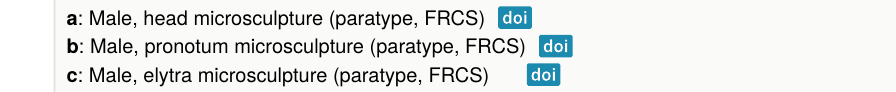
Pronotum : Broadest at the base. Base completely straight to posterior angles. Posterior angles form a right angle, while the tip of the angle itself is slightly rounded. From posterior angles to anterior angles, the pronotum is gently curved inwards. The sides and the anterior angle have a fi ne groove along the entire margin. Transverse microsculpture slightly less distinct than on the head, individual grooves narrowly